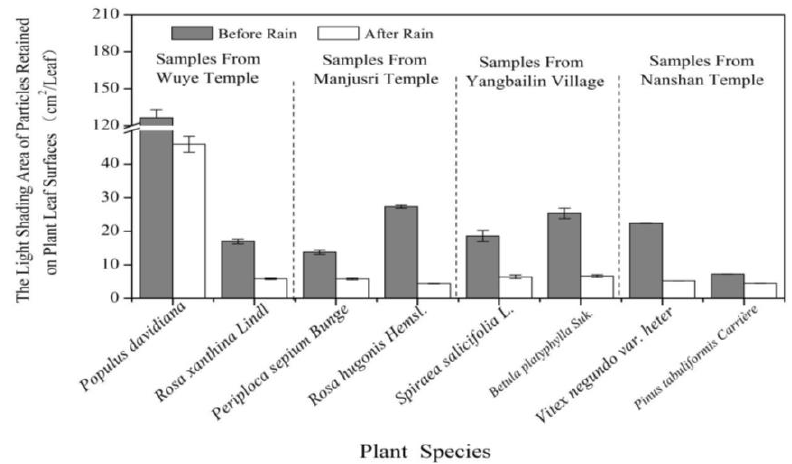
Figure 3. Light shaded area caused by particles on different plant leaves.